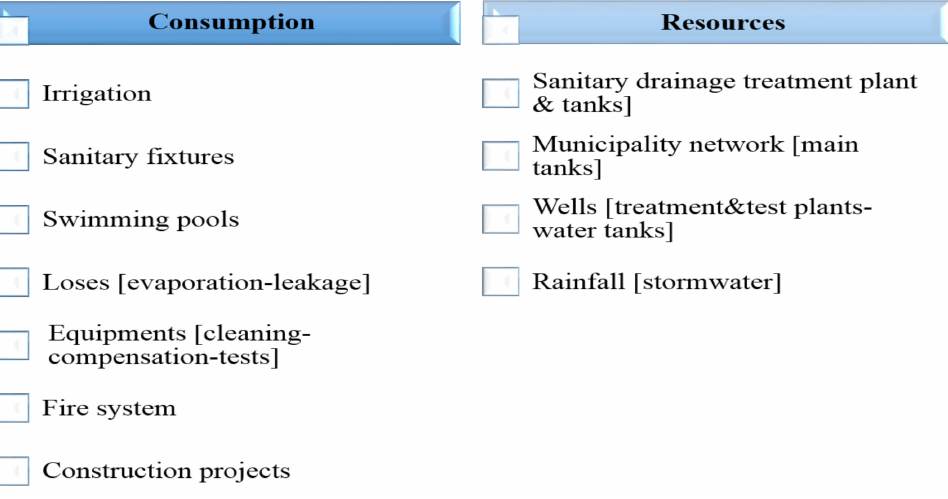
Figure 1. KFU water resources and consumption.